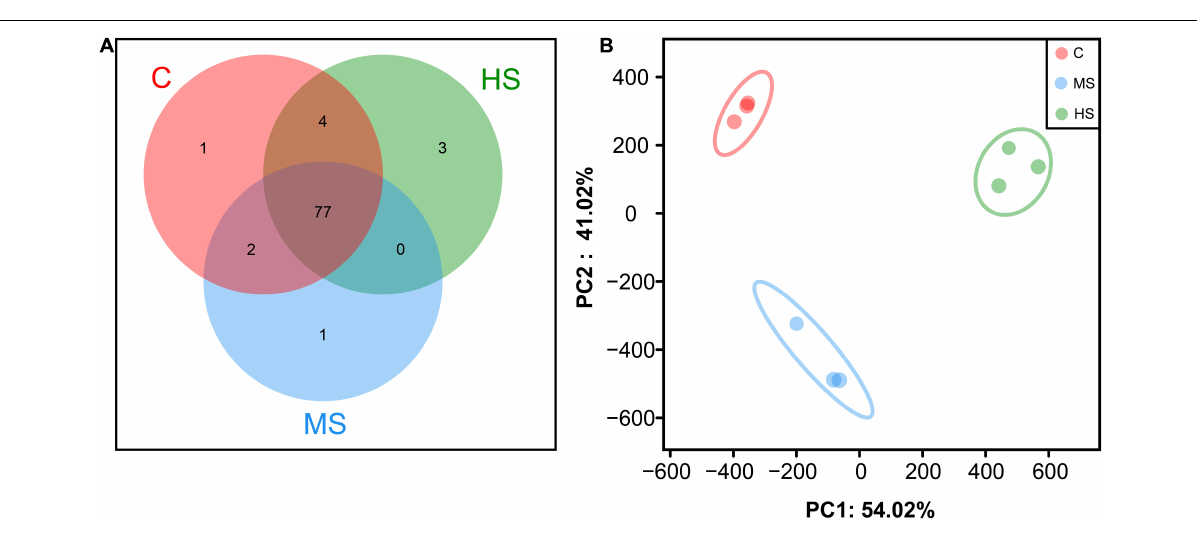
FIGURE 4 | Species composition analysis among different groups. (A) Venn comparison diagram of different groups. (B) Principal Component Analysis